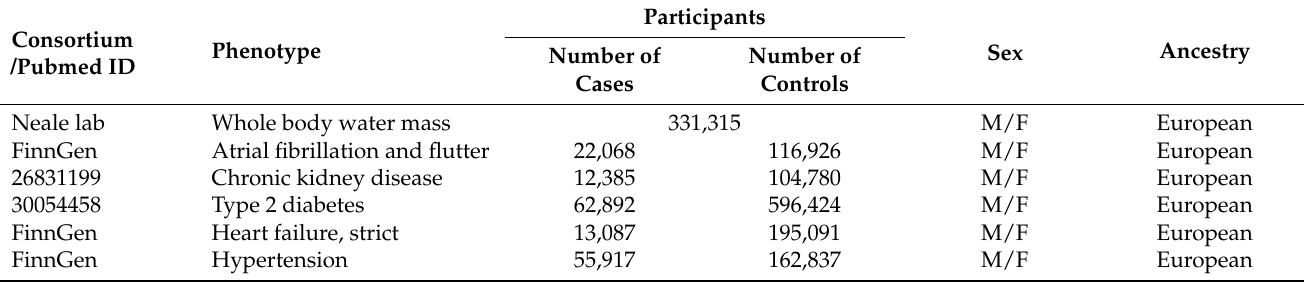
Table 1. Details of the GWASs included in the Mendelian randomization. M, male; F,